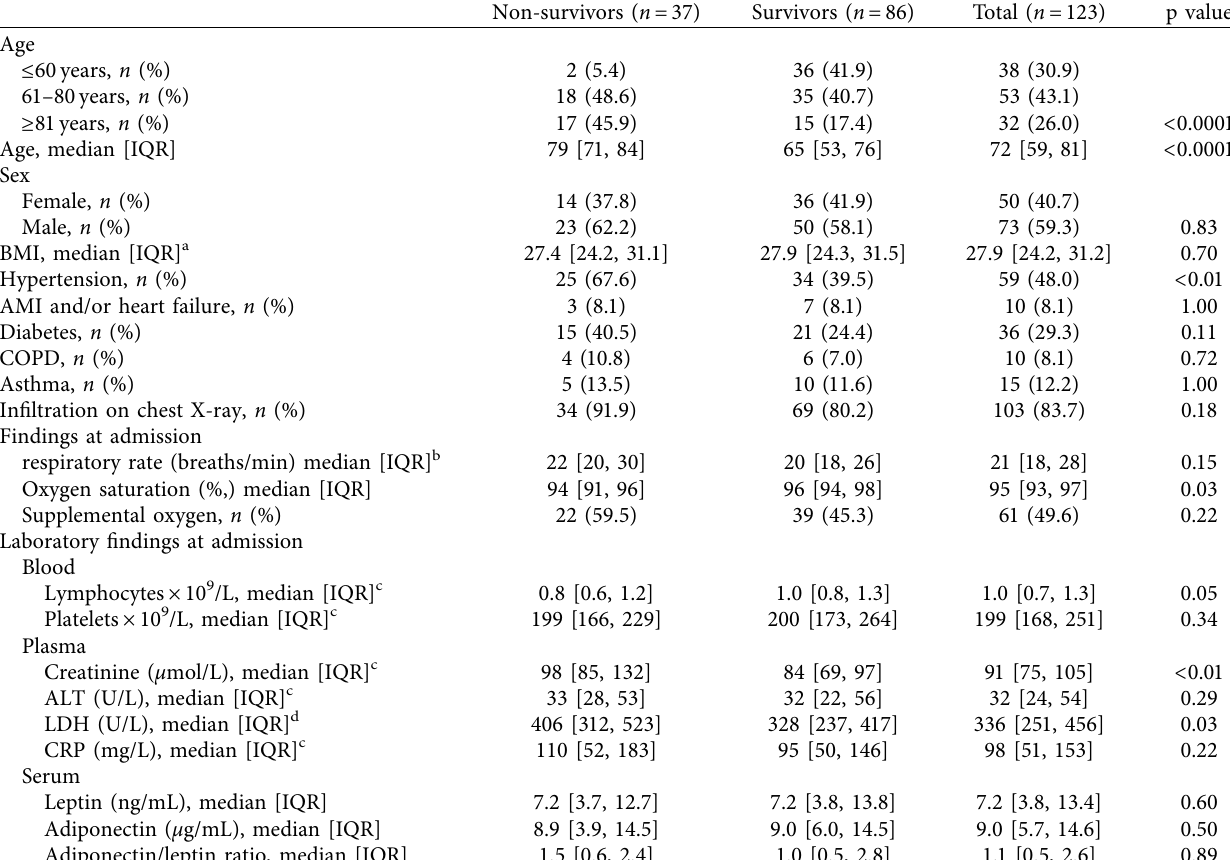
Table 1: Characteristics, vital parameters, and laboratory fndings at admission of patients hospitalized with